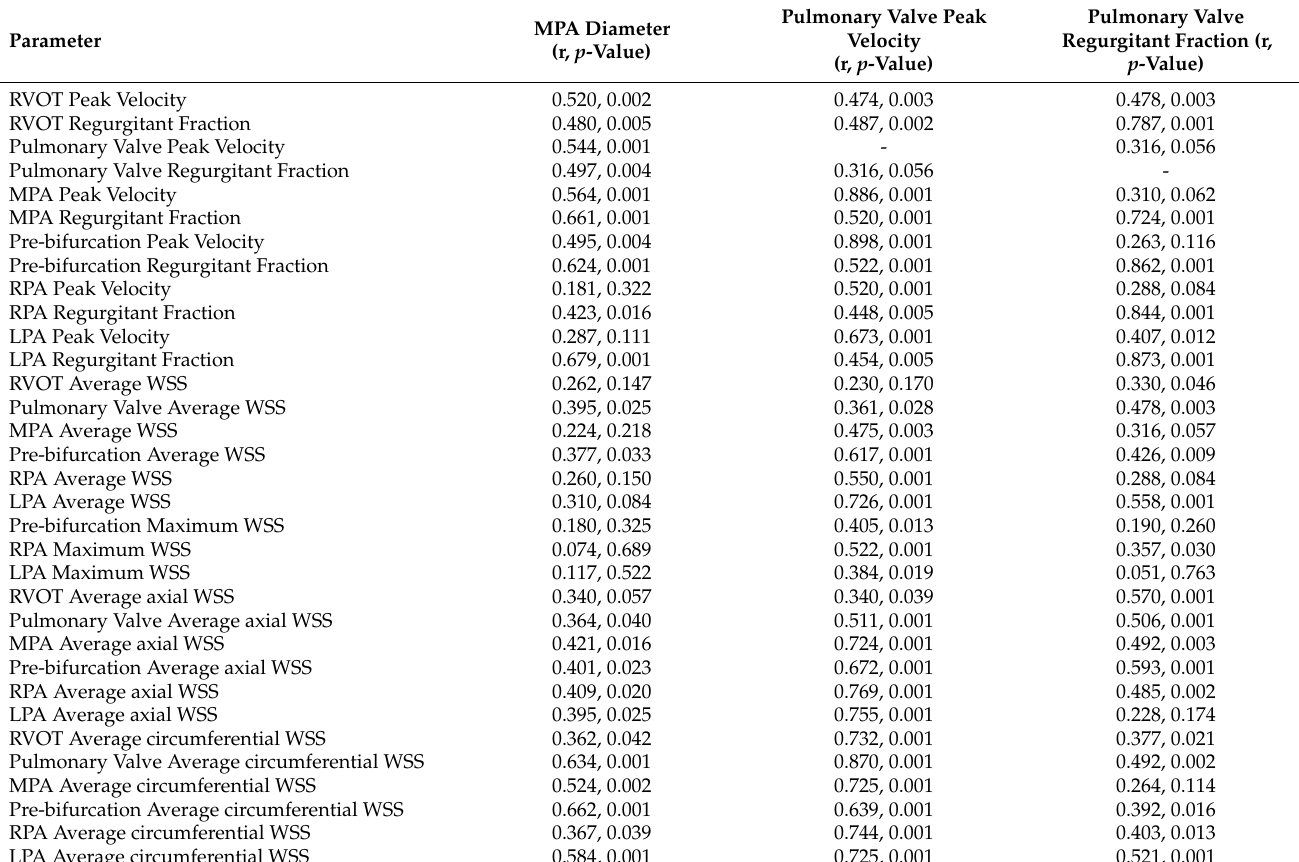
Table 4. Correlations with main pulmonary artery diameter, pulmonary valve peak velocity, and regurgitant